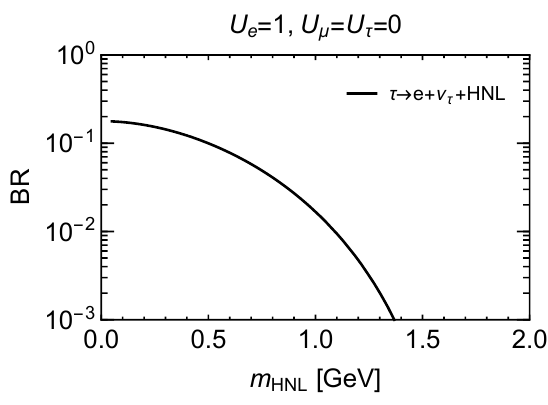
Figure 21 . The same plot as figure 13 but for τ lepton.